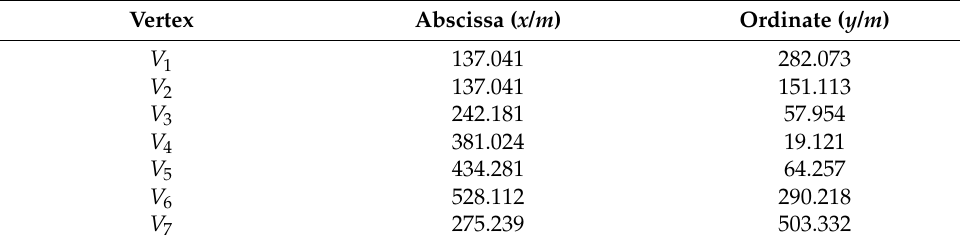
Table 2. Rectangular coordinate of the vertices of detection area 1.